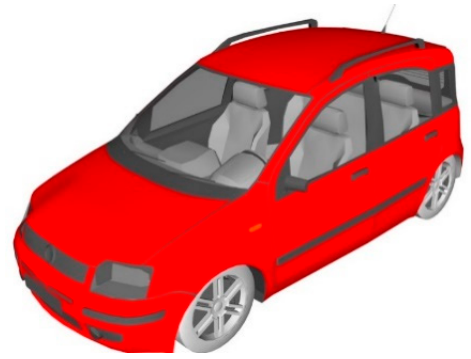
Figure 2. Sim-Panda 3D model.